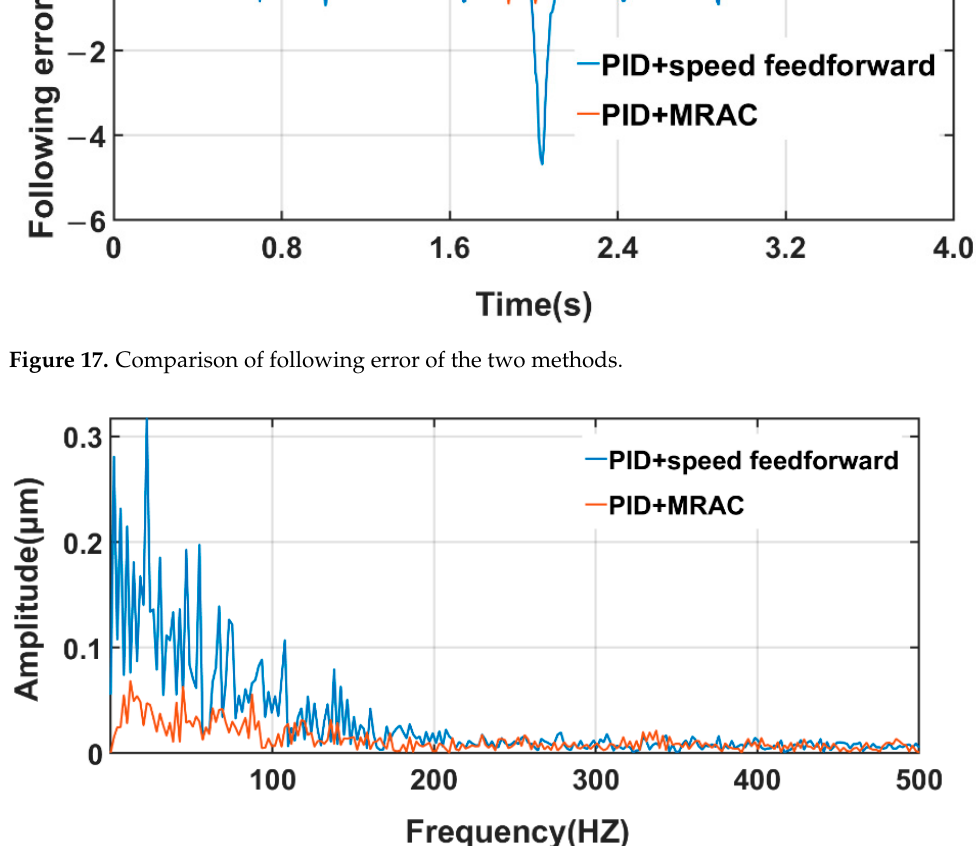
Figure 18. Frequency-spectrum analysis of following error. To verify the applicability of the control method in this paper, the relatively fast sine speed command was used for the processing experiment (the average linear velocity of circle processing was 3 m/min, and the radius was 40 mm). Following error and error- spectrum analysis are shown in Figures 19 and 20.